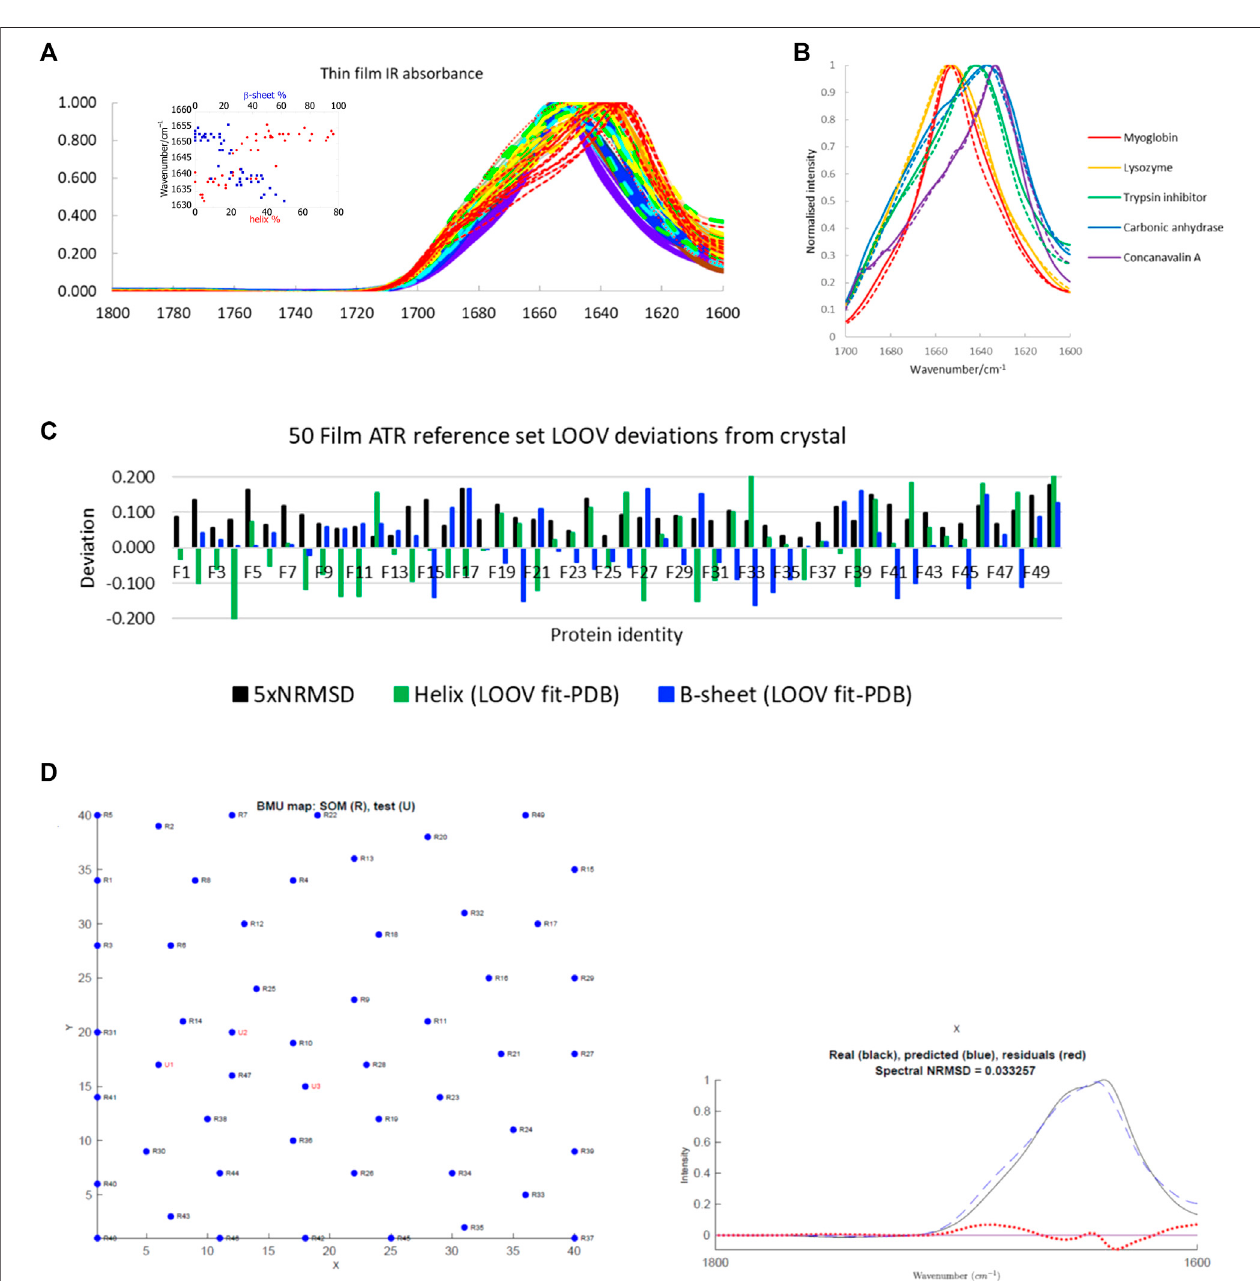
FIGURE 1 | (A) A 50-protein thin- fi lm ATR reference set (see Supplementary Table S1 for list of proteins). Inset: Amide I maxima plotted versus total α -helix red and β -sheet blue content. Proteins F1 − F7 ( > 60% helix) are purple; F8 − 14 (45 – 59% helix) are blue; F15 − 21 (34 – 44% helix) are turquoise; F22 − F28 (26 – 33% helix) are green;F29 − F33,F36,F38(17 – 25%helix)areyellow;F34,F35,F37,F39,F40(10 – 16%helix)areorange;F41 − F50( < 10%helix)areredwiththeunfoldedF50dotted. (B) Overlay ofsome normalised ATR thin- fi lm (solid lines)and aqueous transmission (dashed lines) spectra. (C) LOOV deviationsof SSprediction from PDBstructures forhelix( α -helix +3 10 -helix)and β -sheetfortheAmide I50-proteinthin- fi lmreferencesetinorderofdecreasinghelix contentfromlefttoright. 5 × NRMSDofthespectral fi t is overlaid. Other category deviations are minus the sum of helix and β -sheet deviations. (D) Phosphoglycerate kinase (F17) LOOV SOMSpec output from 50-protein fi lm reference set for a relatively poor quality example. In the map, U1, U2, U3 are the best matching nodes for the test protein. These can be expressed as linear combinationsoftheirneighbouringreferencesetnodes.Theproteinscanbeidenti fi edfrom SupplementaryTableS1 intheSM,bynotingthatthetestproteinisF17in thereferenceset,soproteinsR1 – R16correspondtoF1 – F16,andR17 – R49correspondtoF18 – F50.The real spectrumisF17 ’ sinputdata,andthe predicted spectrum is the SOMSpec